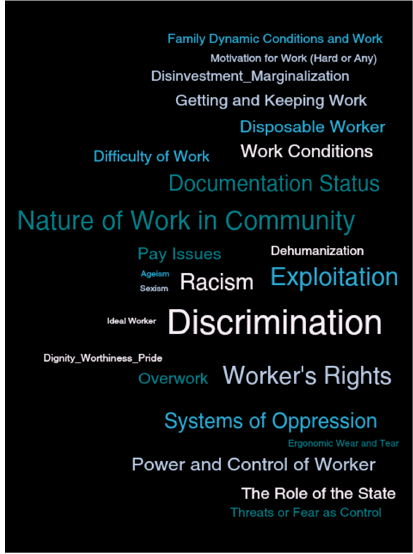
Figure 3. Analytic Code Word